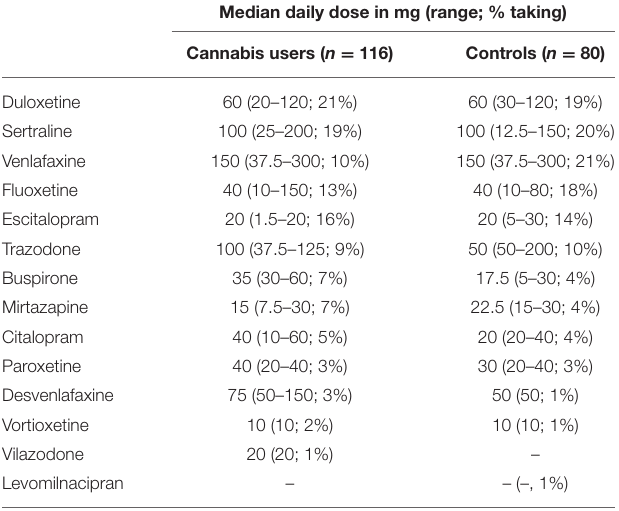
TABLE 2 | Use of serotonergic